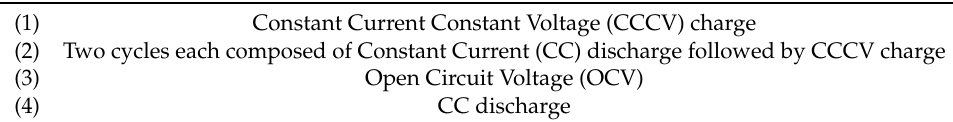
Table 1. Electrochemical test protocol.